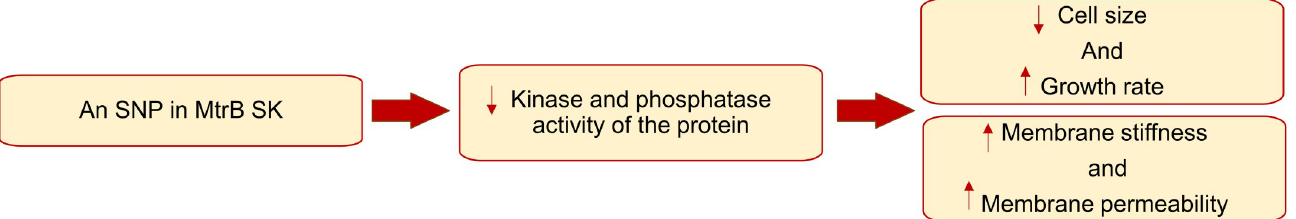
Fig 6. A schematic describing the downstream changes caused by the SNP in the MtrB SK via its altered signalling.